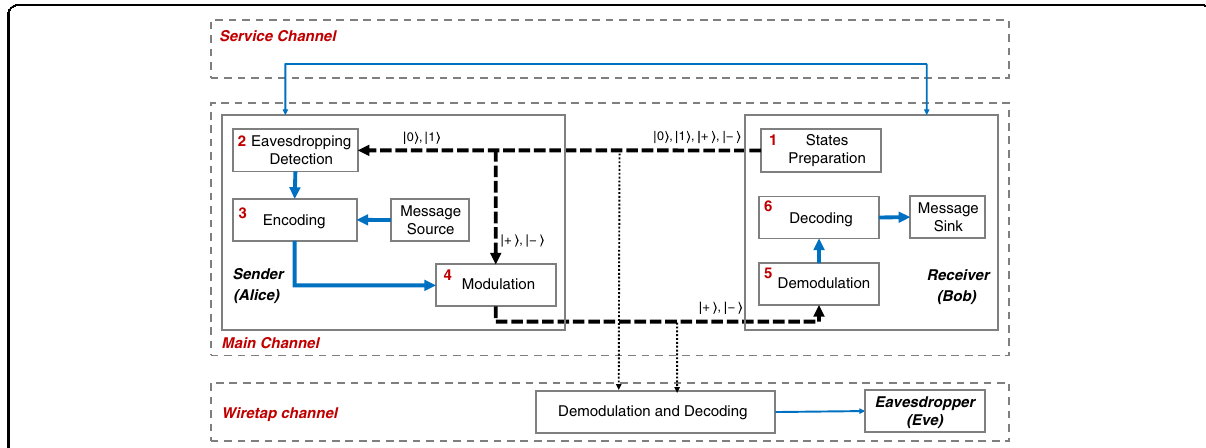
Fig. 1 Illustration of the proposed protocol. The main channel and wiretap channel are discrete and memoryless. The service channel is a classical authenticated noiseless public channel, which transmits only the associated auxiliary data. The blue lines are classical, while qubits are transmitted over the black dotted